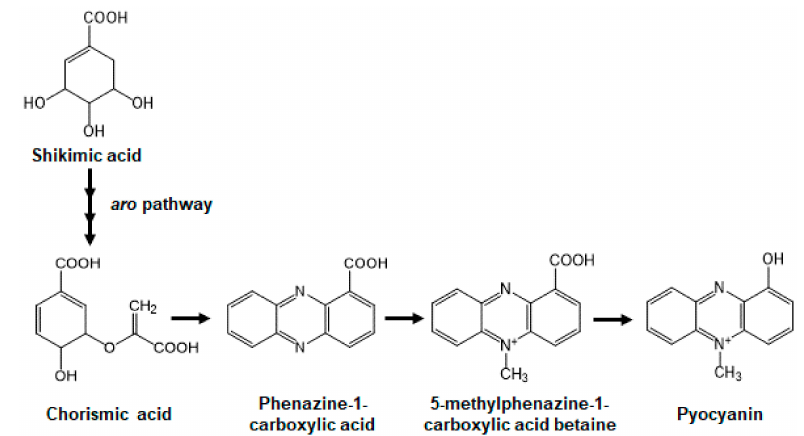
Figure 1. The pathway of pyocyanin production in P. aeruginosa .